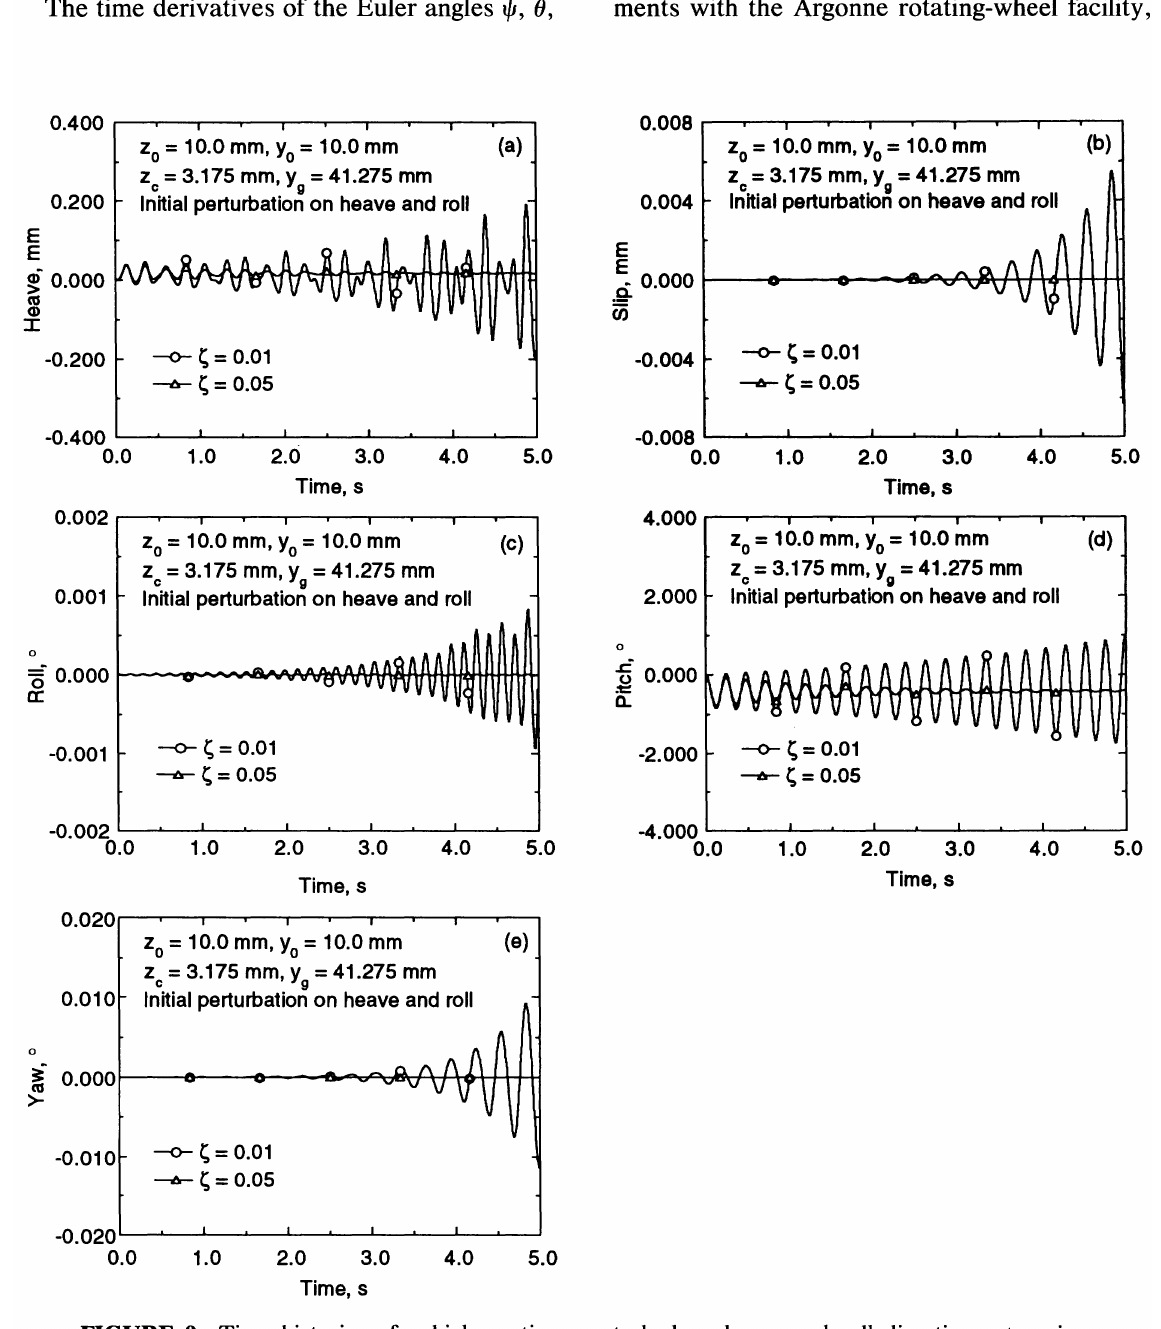
FIGURE 9 Time histories of vehicle motions perturbed on heave and roll directions at various damping